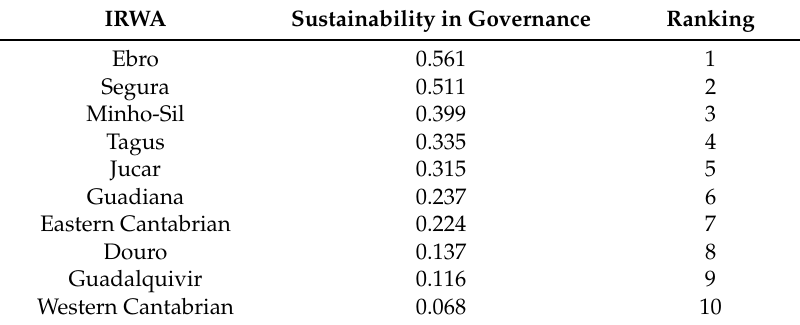
Table 9. Governance sustainability of